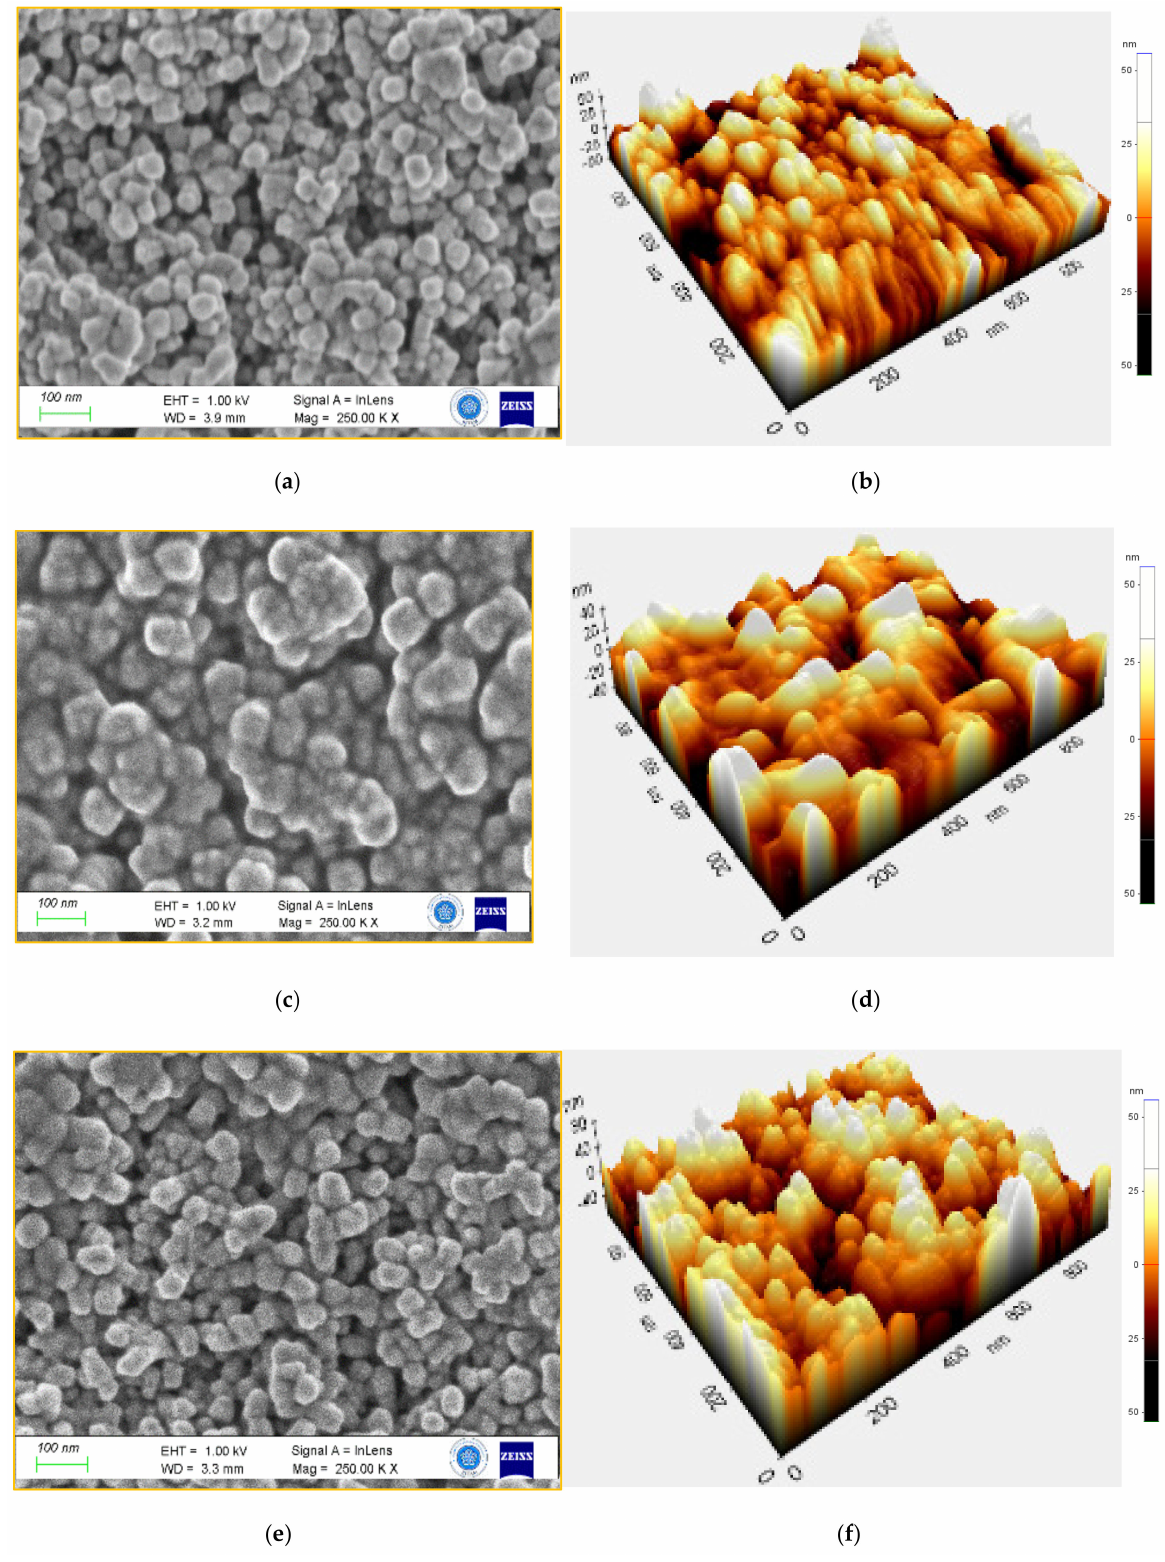
Figure 6. Morphological and Topographical analysis of S4 ( a , b ), S5 ( c , d ), and S6 ( e , f ) samples. The calculation of the Urbach energy ( E U ) evolution provides a clue concerning the transmittance fall observed (Figure S5a,b). E U is visible in low crystalline, disordered, or amorphous materials with localized states in the standard bandgap due to